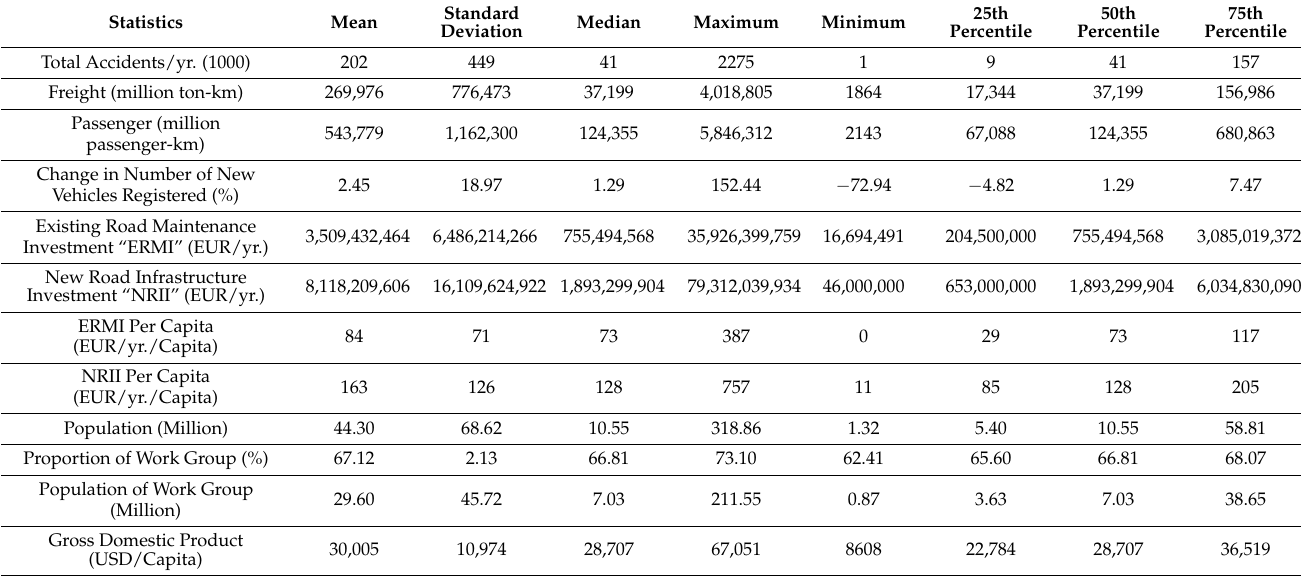
Table 1. Basic statistics of